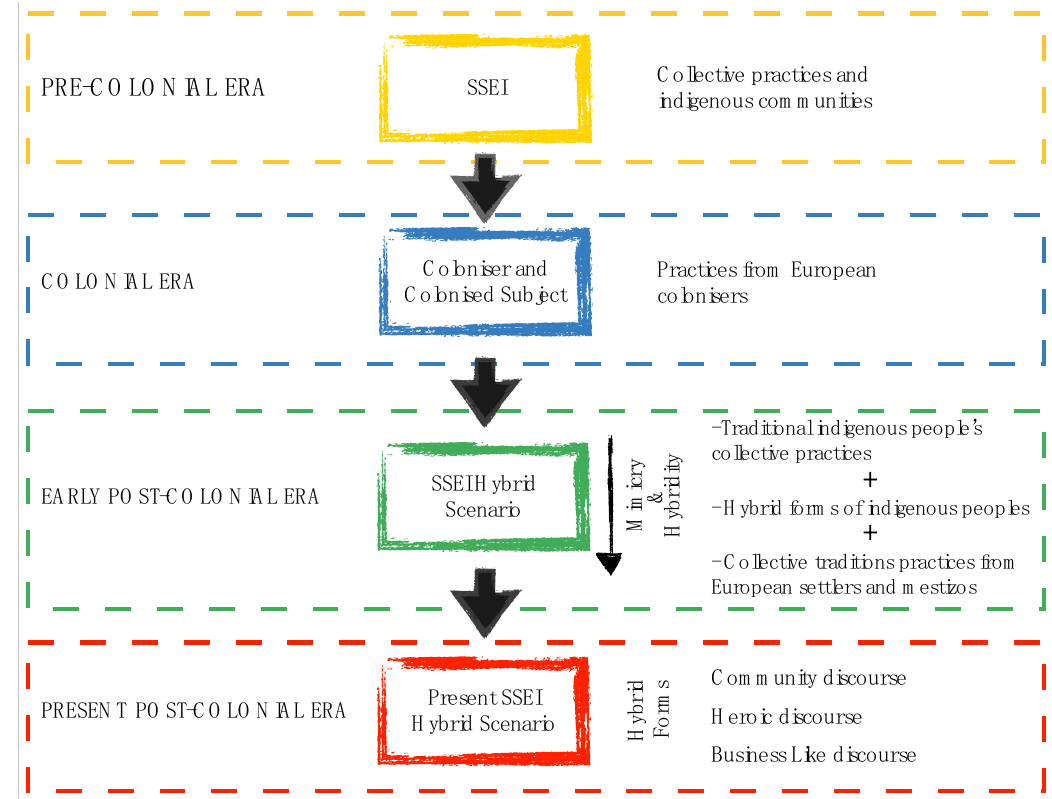
Figure 1. The historical evolution of SSEI discourses in Colombia drawing upon a postcolonial lens.